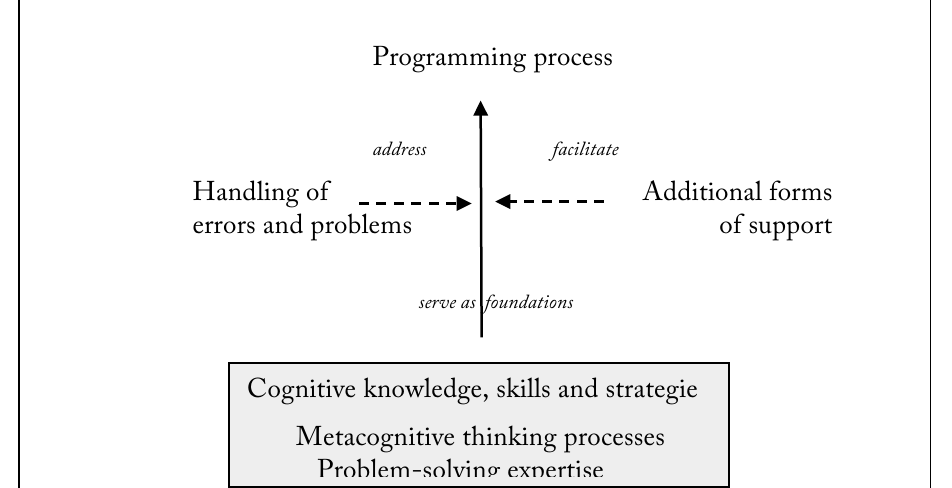
Figure 2: An integrated theory of the themes that emerged